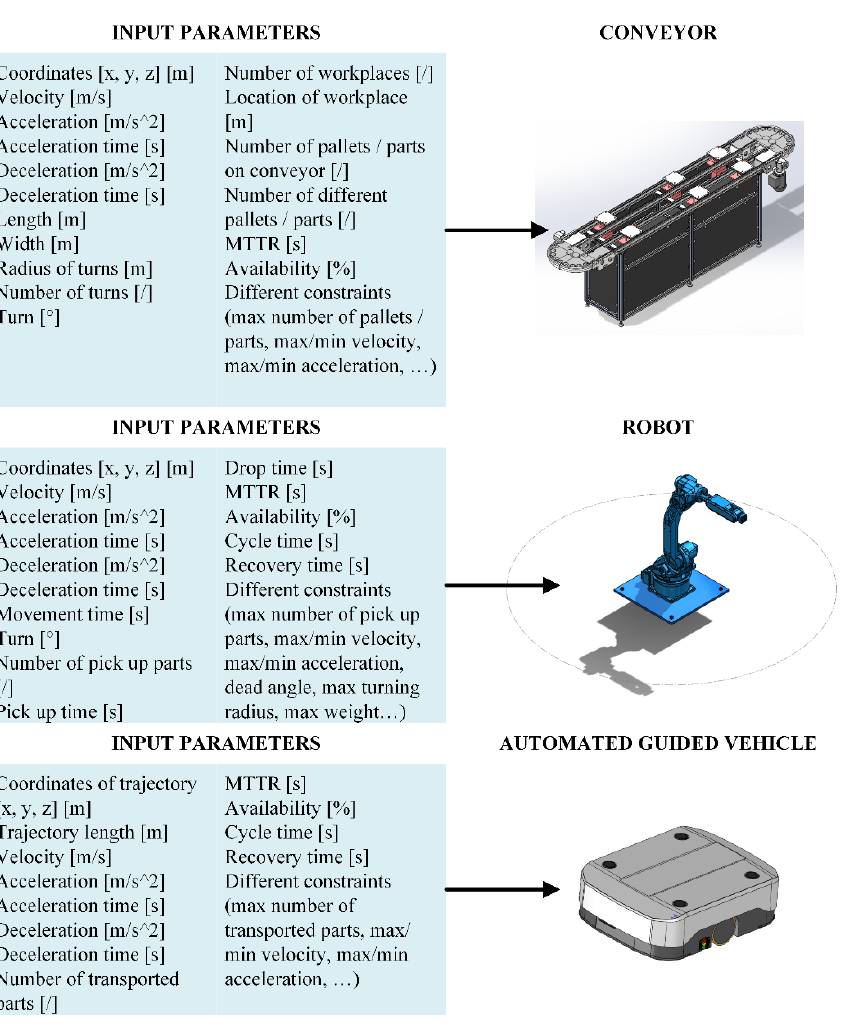
Figure 6. Examples of “Logistics” building blocks.